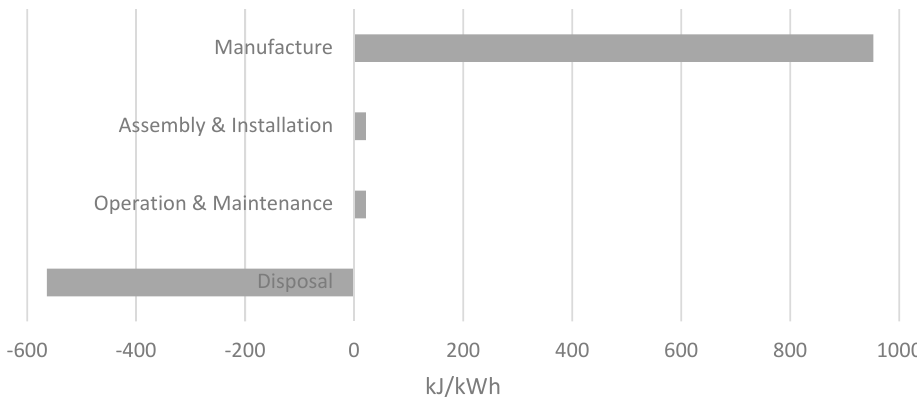
Figure 8. Cumulative Energy Demand (CED).